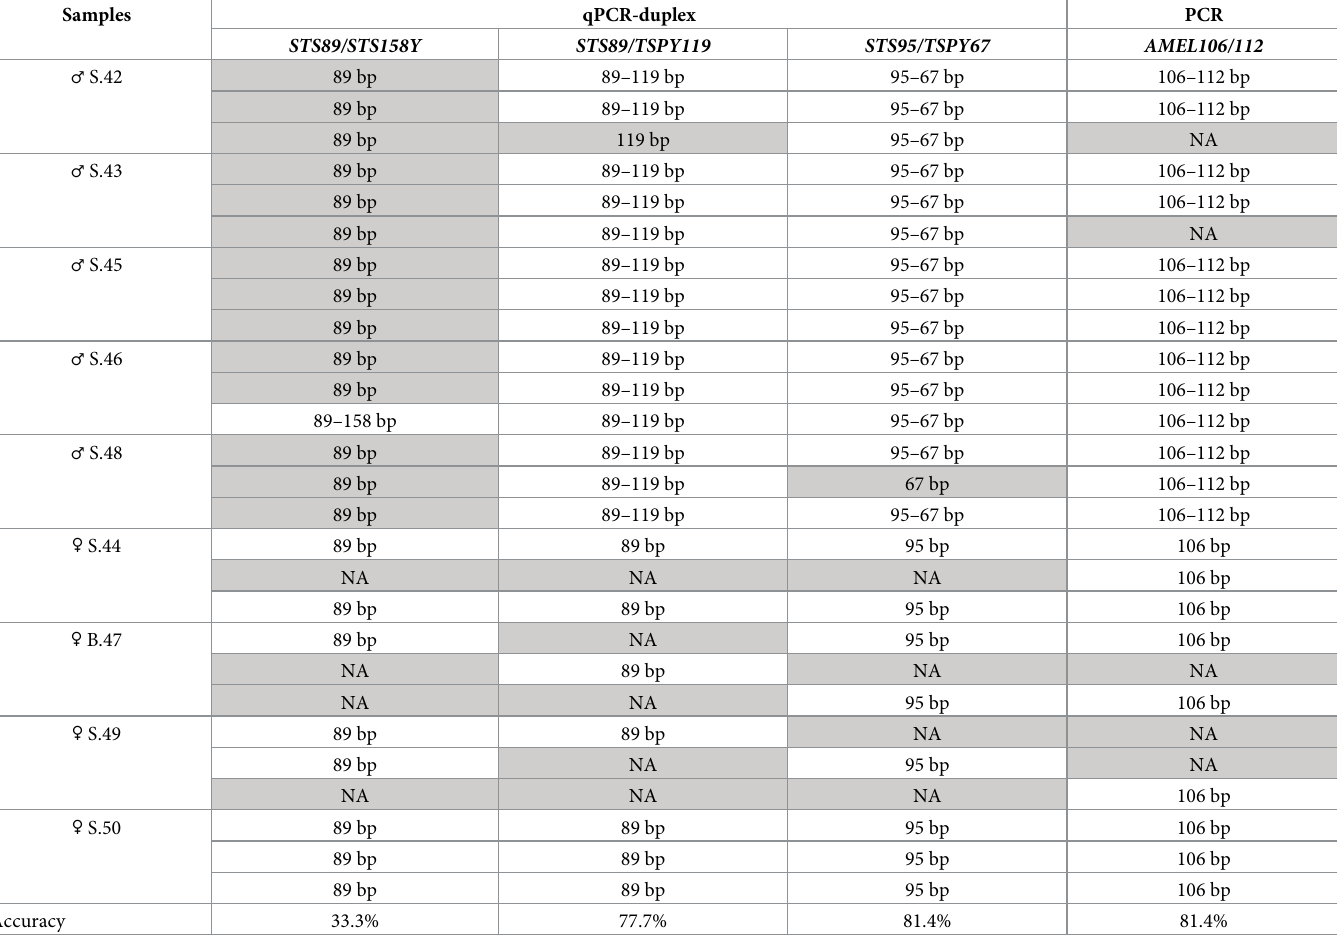
Table 4. Accuracy of the qPCR-duplex and qPCR method on ancient DNA. The table shows the accuracy of the tests capable of identifying sex; amplicons obtained in qPCR-duplex and in PCR were analyzed through the melting curves and the electrophoretic run respectively. Three aDNA extractions were performed for each skeletal sample, the analysis was conducted with two technical replicates for each sample. In both qPCR-Duplex and PCR, 150 pg of DNA was used in a 20 μ l reaction system. Gray cells amplification anomaly. NA) not amplified.